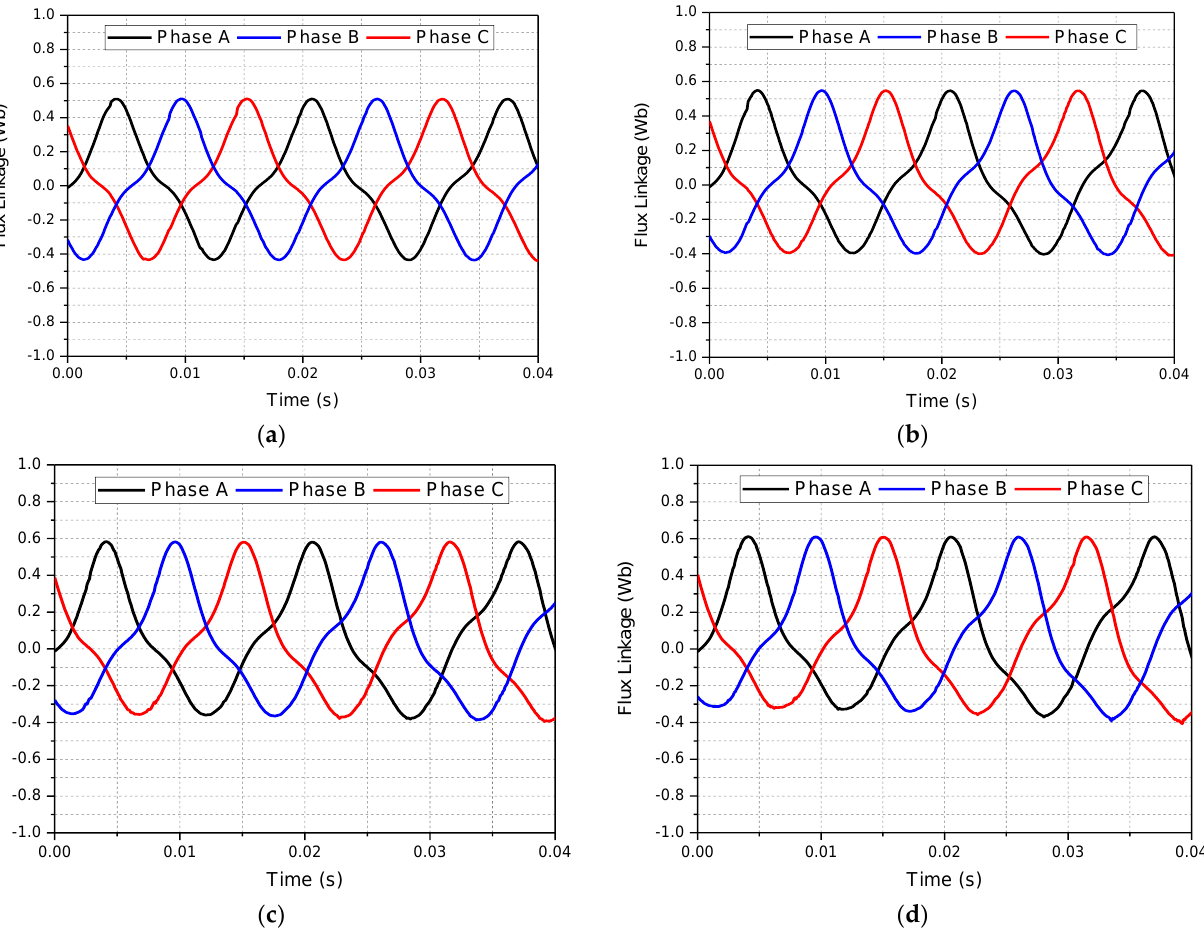
Figure 6. Flux linkages of the machine having ( a ) 0.6 A, ( b ) 1.2 A, ( c ) 1.8 A, and ( d ) 2.4 A dc offset for each phase of armature currents.